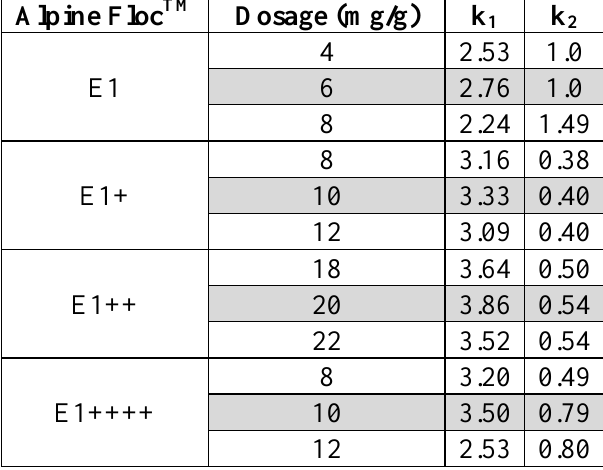
Table 2. Fitting of Equations 2 and 3 to the kinetic curves, values of k1 and k different PEL (dashed lines correspond to the optimum dosage for each